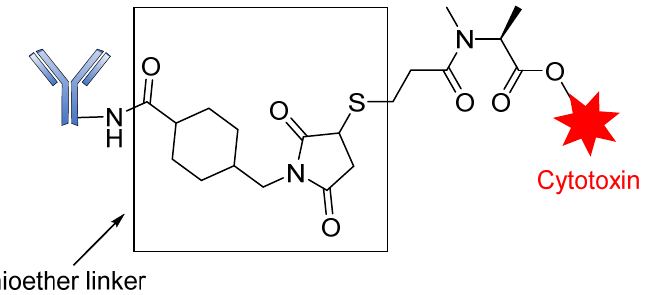
Figure 16. Structure of T-DM1 containing a thioether linker.